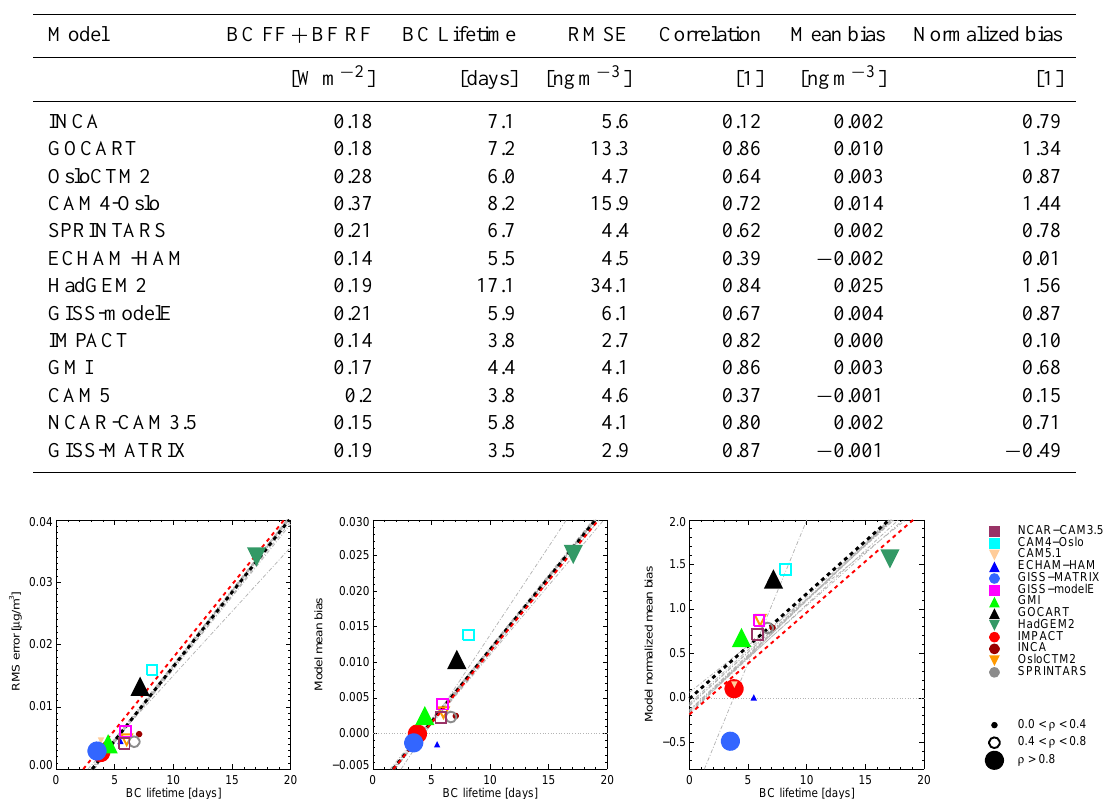
Table 3. BC FF + BF RF and BC atmospheric lifetime of BC for the models used in the present study. Bias, RMSE and correlation coefficients are for comparisons of each model with HIPPO data for all Pacific regions (P1–P5). Each calculation is based on 72 data points.